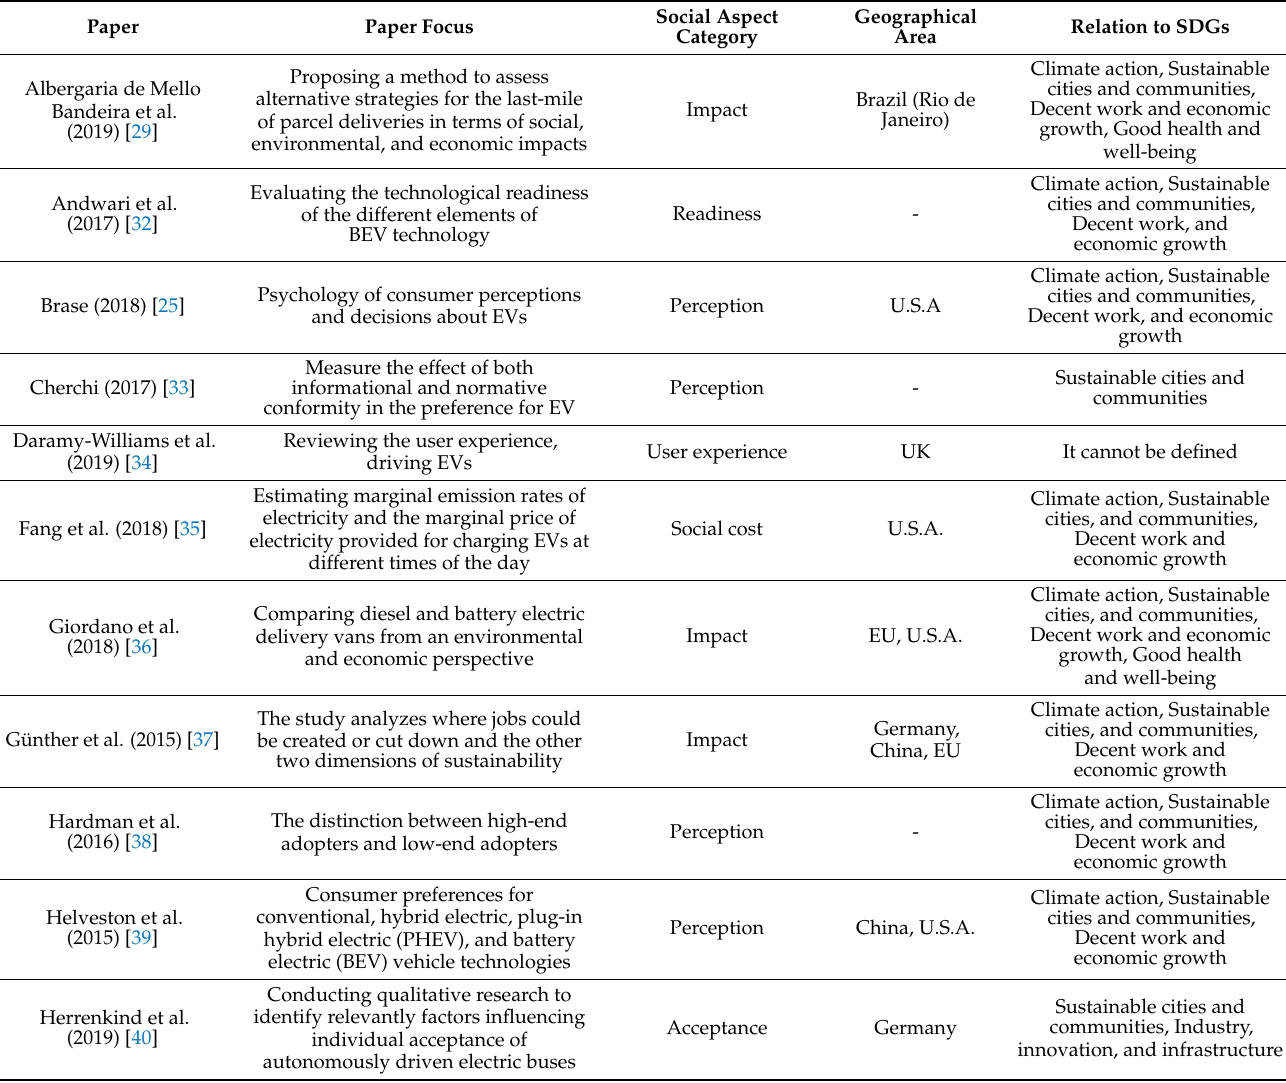
Table 2. Research focus, category, geographical area, and relation to the sustainable development goals (SDGs) (alphabetically). Paper Paper Focus Social Aspect